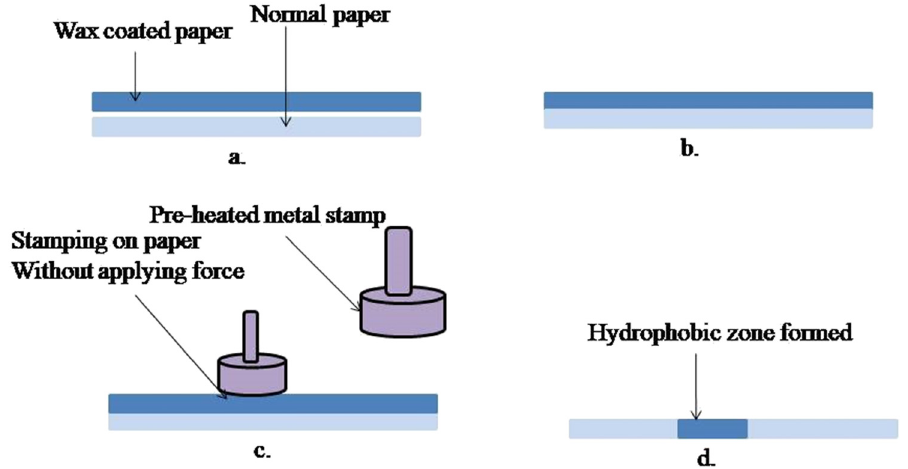
Figure 5: Metal stamping for PAD fabrication: ( a ) aligning wax coated and simple paper, ( b ) placing wax coated paper over the normal paper, ( c ) pre - heated stamp is taken and placed over the wax paper, and ( d ) hydrophobic barrier is formed in the shape of the pattern on metal